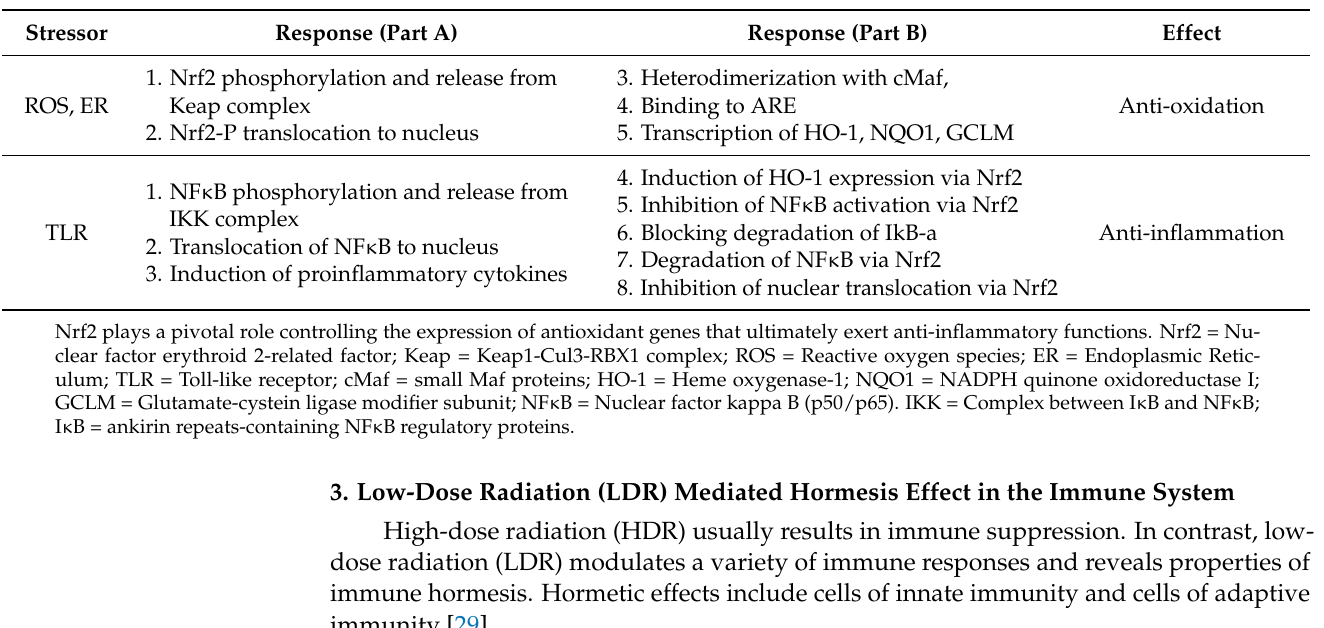
Table 2. Nrf2 and its role in anti-oxidative and anti-inflammatory cellular